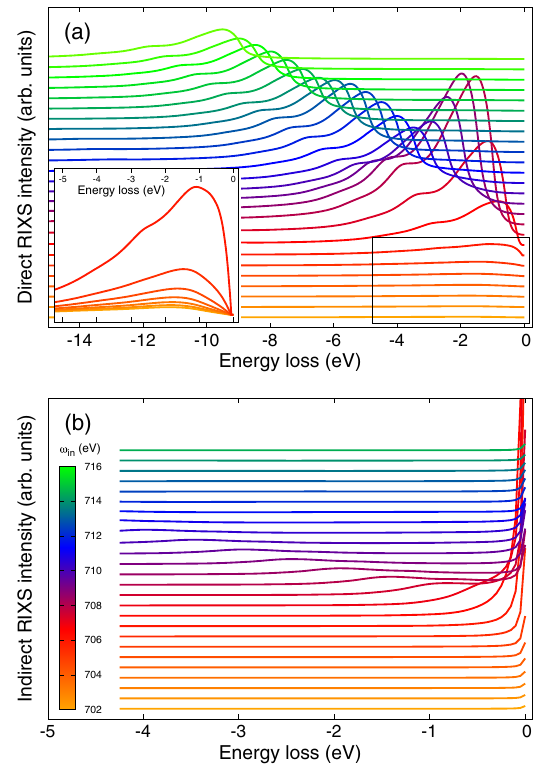
FIG. 8. Calculation of the direct (a) and indirect (b) RIXS contributions at the Fe L 3 edge of BaFe 2 As 2 according to Eqs. (13) and (14), respectively. Loss profiles for selected incident photon energies, from 702.5 to 715 eV in steps of 0.5 eV, are displaced vertically. The color bar designating the incident photon energy in (b) applies in (a) as well. The calculations of the direct channel (a) reproduce the Raman-to- fluorescence crossover at the absorption threshold. The inset provides an expanded view of the first 5 eVof loss for the below- threshold Raman-like region. Within the indirect channel (b), the elastic line extends to finite energy loss related to secondary electron-hole pair excitations captured by the quasiboson spectral function. Calculations use Doniach-Sunjic spectral functions as described in the text. A core-hole lifetime equivalent to 0.2 eV HWHM broadening is applied to the intermediate-state reso- nance. The unexpected fluorescence feature in (b) is discussed in the text.